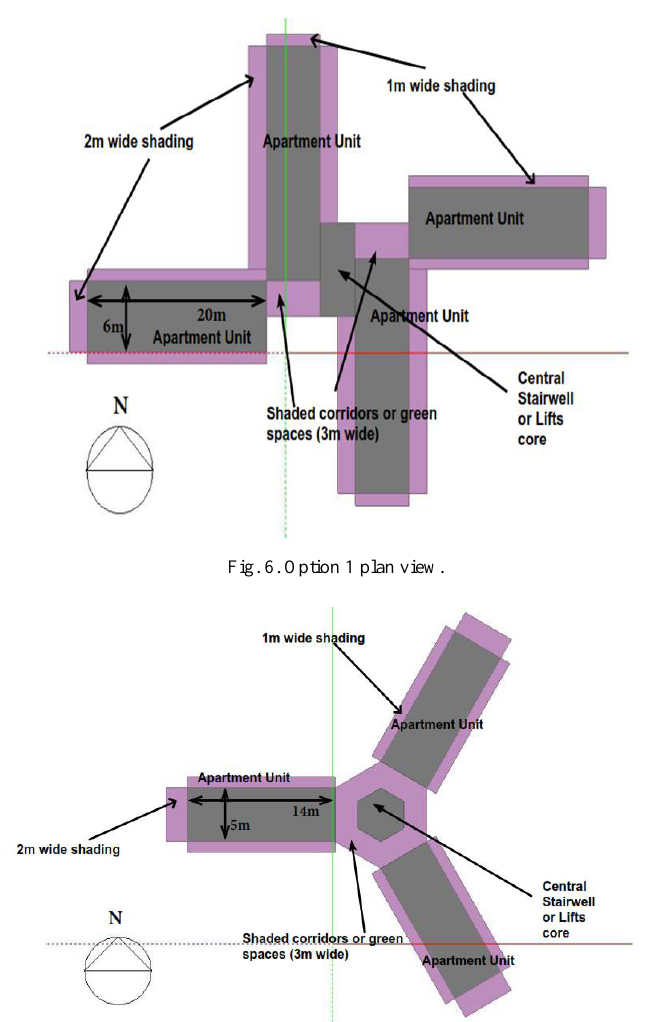
Fig. 7. Option 2 plan